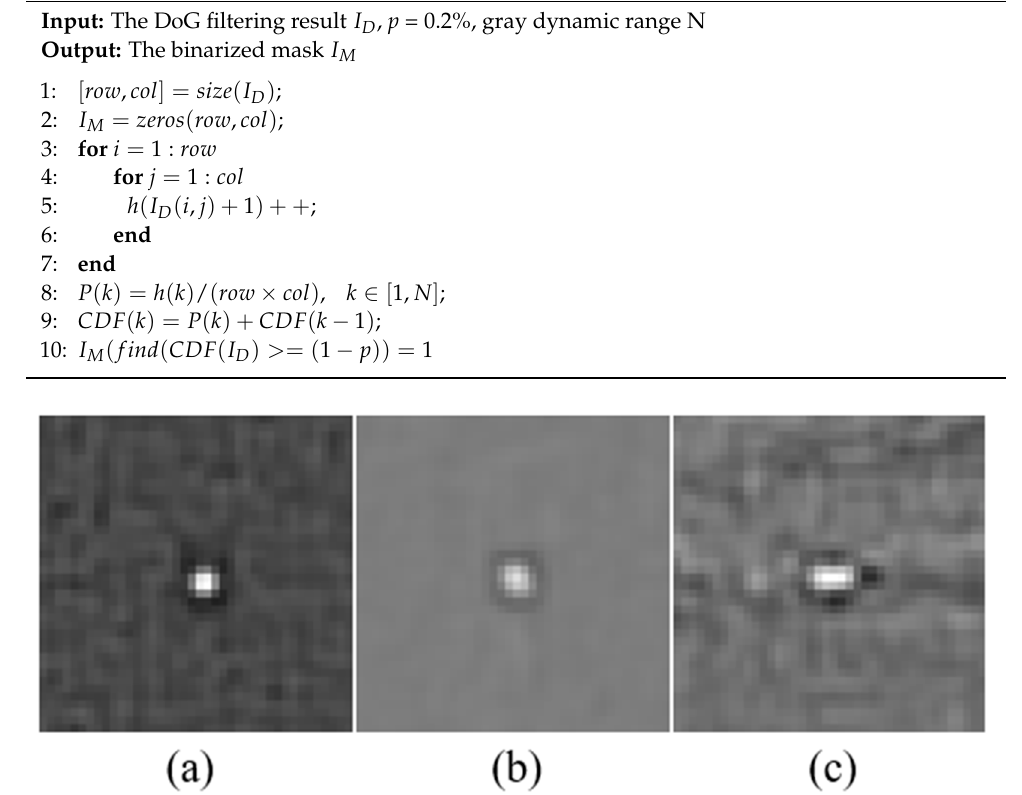
Algorithm 1. Pseudocode for Binarized Mask Calculation.